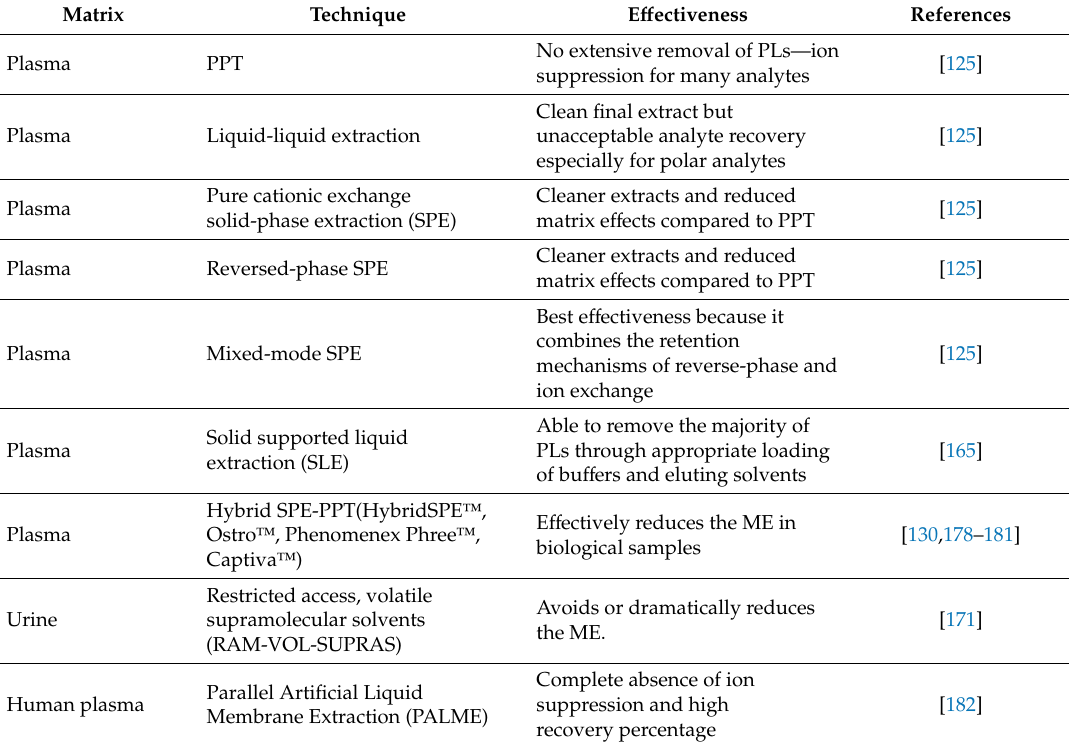
Table 5. List of the phospholipid removal